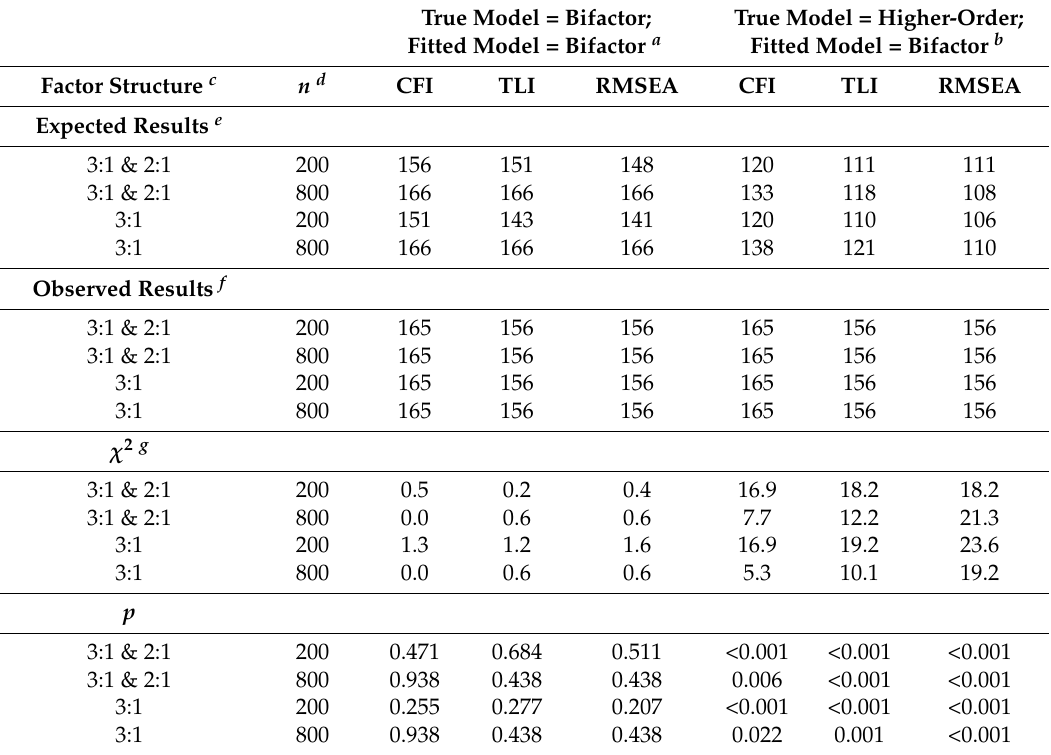
Table 2. χ 2 Tests Comparing Observed Counts of Fit Statistic Results Across all 166 Analyses to those Expected from Morgan et al.’s [43] Monte Carlo Simulation. True Model = Bifactor; Fitted Model = Bifactor